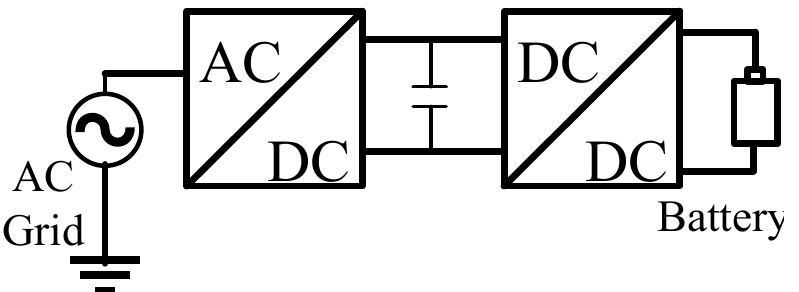
Figure 5. Structural diagram of the two-stage converter. Non-isolated bi-directional circuits are simple in construction, cost-effective, and sta- ble in operation. Standard non-isolated circuits include half-bridge bi-directional DC/DC converters, BUCK-BOOST bi-directional DC/DC converters, Cuk bi-directional DC/DC converters, and Sepic/zeta bi-directional DC/DC converters.